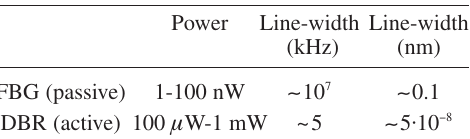
Table I. Comparison of FBG and DBR perform-